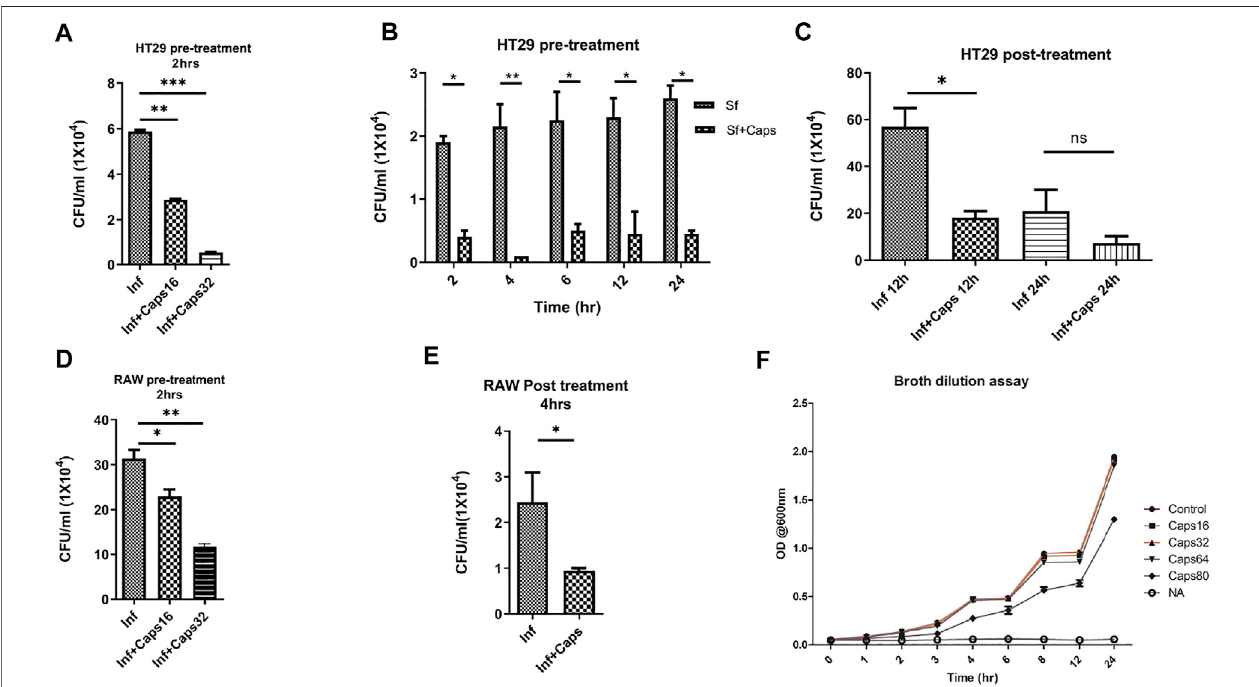
FIGURE 1 | Intracellular S. fl exneri growth was inhibited by capsaicin (Caps) in both intestinal and macrophage cells. (A) Infection assay was performed in HT29 cells with different concentrations of capsaicin (Caps). Brie fl y, cells were pre-treated (16 µM, 32 µM) with Caps for 2 h followed by S. fl exneri infection (MOI 200) for 2 h. Finally,gentamicintreatmentwasdonetokillextracellularbacteria.Cellswerelysedandplatedovernightforcountingthenumberofcolonies(CFU/ml).Graphsrepresent CFU/ml of intracellular S. fl exneri . One-way ANOVA was performed. (B) Caps pre-treatment (16 µM) for 2 h followed by S. fl exneri (MOI 200) infection at different timepoints(2,4,6,8,12,24 h)wasdone.Two-wayANOVAwasperformed. (C) HT29cellswereinfectedwithMOI200followedbypost-treatmentwithCaps(16µM)for 12 and 24 h. One-way ANOVA wasperformed. Cells werelysedand platedtocount thenumber ofcolonies. (D) RAW 264.7cells wereinfected with S. fl exneri MOI100 for 30 min after 2 h Caps pre-treatment. Cells were lysed and plated to count the number of colonies One-way ANOVA was performed. (E) RAW264.7 cells were infected with S. fl exneri MOI 100, followed by post-treatment with Caps (16 µM) for 4 h. Graph represents CFU/ml of intracellular S. fl exneri . One-way ANOVA was performed. (F) A broth dilution assay was performed in the presence of DMSO control, 16, 32, 64, and 80 µM Caps and nalidixic acid (10 μ g/ml) (NA) followed by